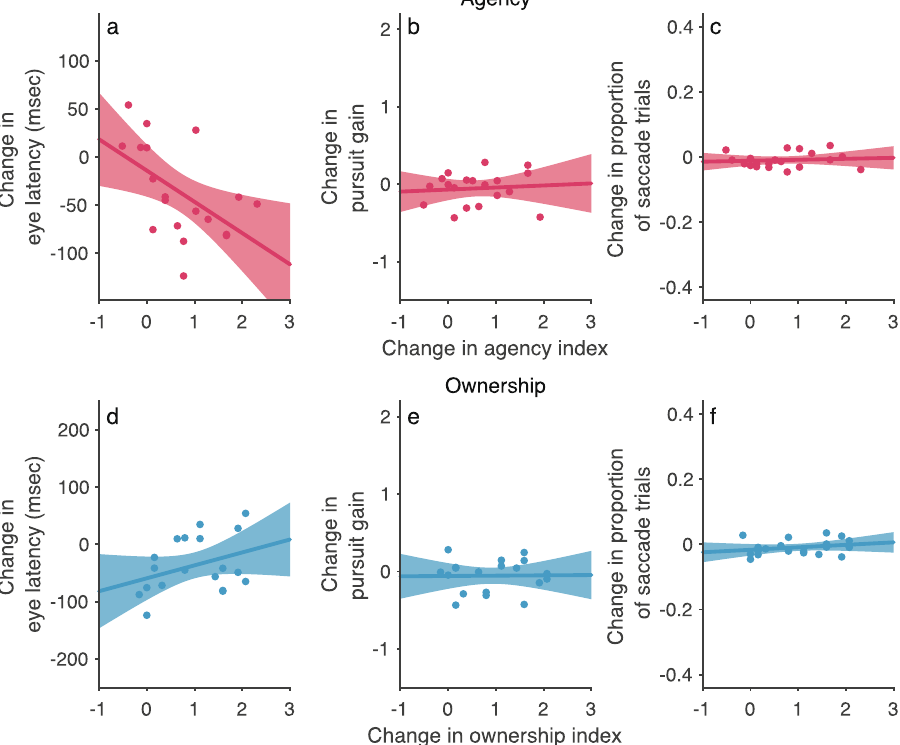
Figure 3. Correlation between body awareness and eye–hand coordination performance in experiment 1 ( n = 20). ( a – c ) Agency. ( d – f ) Ownership. Change in eye–hand coordination performance [i.e., eye latency ( a , d ), pursuit gain ( b , e ), and proportion of saccadic trials ( c , f )] was defined as the change in performance when the sense of agency or the sense of body ownership became stronger in the active-synchronous condition compared with the active-asynchronous condition. One participant was excluded from Spearman’s rank correlation analysis for both eye latency and pursuit gain (see Methods for